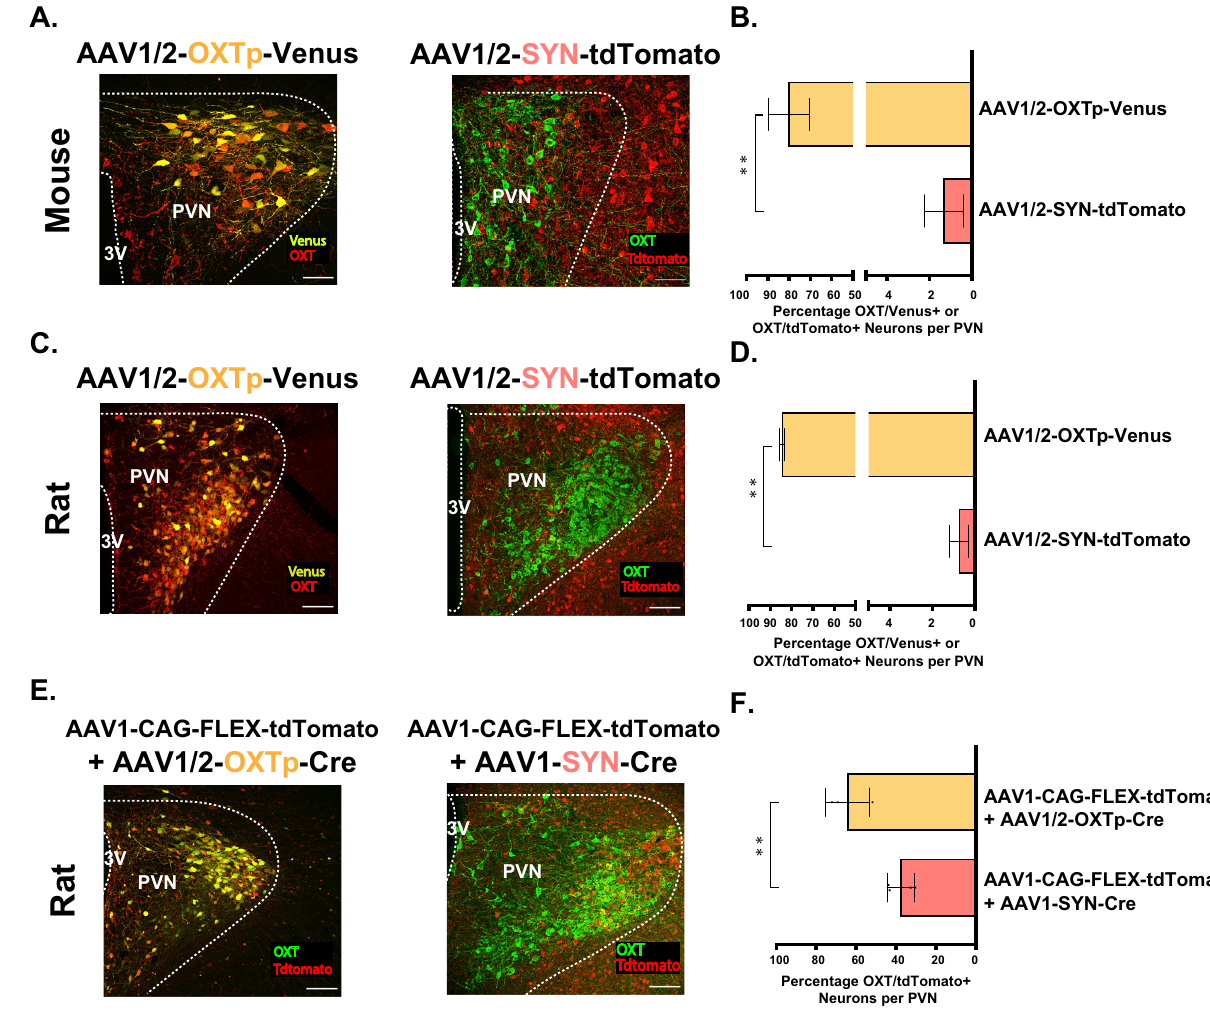
Figure 3. OXT promoter and not viral serotype confers high degree of specificity and transducibility for viruses targeting OXT neurons. ( A ) Confocal images of mice brain tissues, three weeks following viral injection in the PVN. Left, injection with AAV1/2-OXTp-Venus, immunoblotting with anti-OXT (red) and Venus is encoded by the virus (yellow). Right, injection with AAV1/2-OXTp-tdTomato, immunoblotting with anti-OXT (green) and tdTomato is encoded by the virus (red). 40×, Scale bar = 50 μm, dotted line demarcates the PVN and the 3rd ventricle; 3 V. ( B ) Bar graphs (± SEM) show the average percentage of OXT positive (OXT+) neurons that also express the virus (Venus + or tdTomato + ) in the PVN. Transduction efficiency is significantly higher for the AAV1/2-OXT-Venus virus. ( C,D ) Same as A and B , respectively, but in rats. Transduction efficiency is significantly higher for the AAV1/2-OXT-Venus virus. ( E ) Confocal images of mice brain tissues, three weeks following viral injection in the PVN. Left, injection with AAV1/2-OXT-Cre + AAV1-CAG-FLEX-tdTomato. Right, injection with AAV1- CAG-Flex-tdTomato and AAV1-SYN-CRE. In both images, immunoblotting with anti-OXT (green) and tdTomato is encoded by the virus (red). ( F ) Bar graphs (± SEM) show the average percentage of OXT positive (OXT+) neurons that also express the virus (Venus + or tdTomato + ) in the PVN. Transduction efficiency is significantly higher for the AAV1/2-OXT-Venus + AAV1-CAG-FLEX-tdTomato combination. 40×, Scale bar = 50 μm, dotted line demarcates the PVN and the 3rd ventricle; 3 V. n = 3 rat per virus with an average of 10 slices per rat PVN. *p < 0.05, **p < 0.005, ***p <